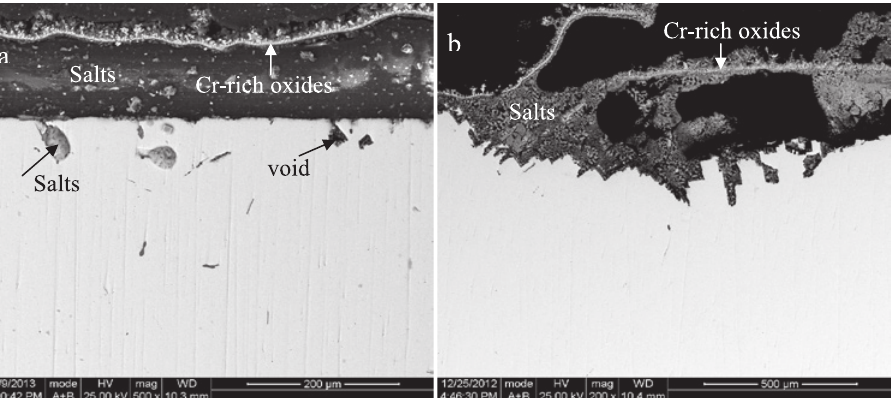
Fig. 9: Cross-sectional morphologies of pure chromium after immersion in molten (Li,Na,K)F at 973 K for 18 h. (a) Cr corroded in the melt; (b) Cr corroded at the melt/gas